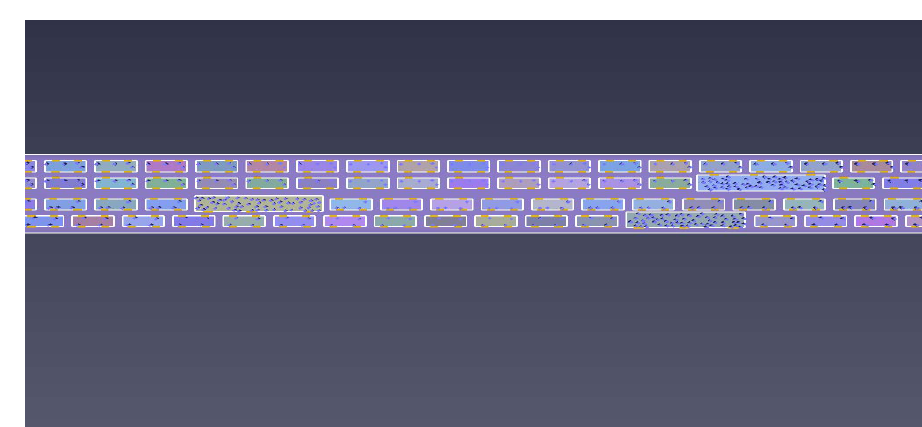
Figure 4 – Simulation presentation of a tunnel with vehicles and occupants inside (the first simulation